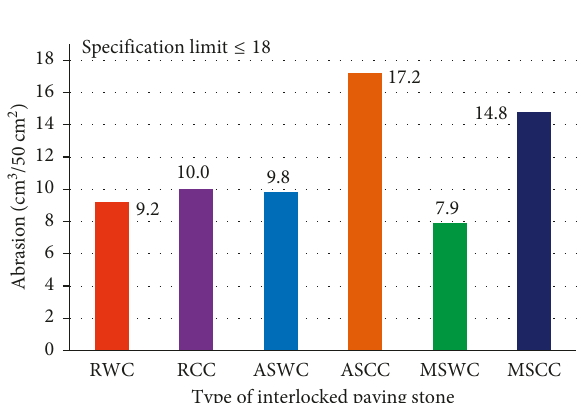
Figure 12: Results of the abrasion test for the interlocked paving